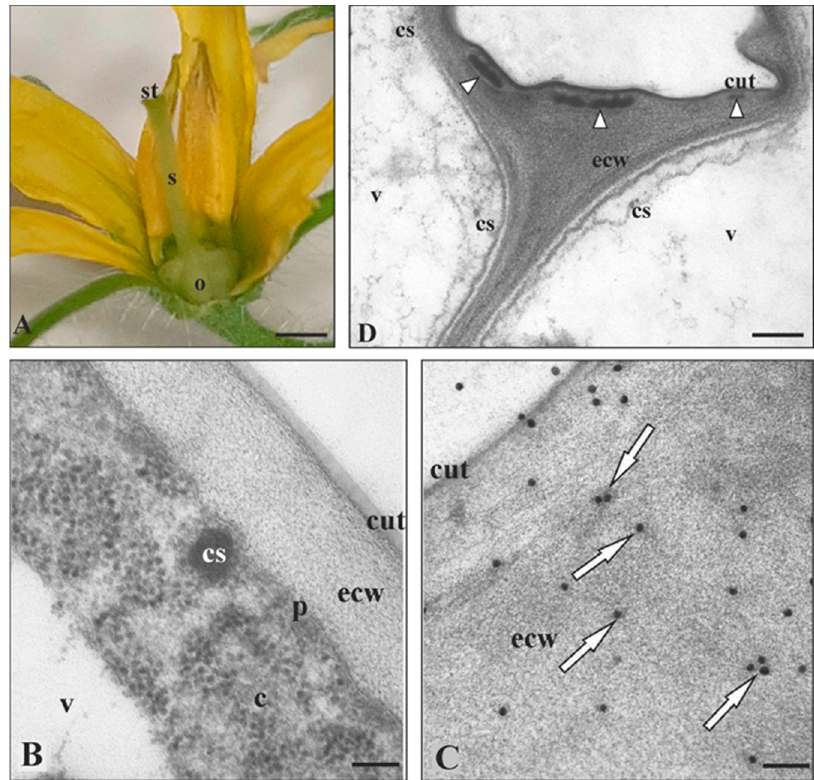
Figure 2. Cutinsome localization and identification in ovary of S. lycopersicum . ( A ) Mature flower with clearly visible ovary five days after anthesis. ( B – D , TEM images) In planta cutinsomes in cytoplasm and external cell wall of fruit epidermis, more or less visible depending on the fixation method. Preparations fixed in glutaraldehyde with ( B , D ) OsO 4 and ( C ) without OsO 4 . ( B ) Cutinsome with electron-dense contents near plasmalemma heading for external cell wall with clearly visible cuticle and ( D ) coalesced cutinsomes (arrow heads) forming cuticle layer. ( C , arrows) Cutinsomes after immunogold reaction with anti-cutinsome antibodies labeled with one to a few 20 nm gold grains. Single grains localize cutinsomes, although these structures are not clearly visible on the external cell wall; c, cytoplasm; cs, cutinsome; cut, cuticle; ecw, external cell wall; o, ovary; p, plasmalemma; s, style; st, stigma; v, vacuole; Bars, ( A ) 700 µm, ( B , C ) 100 nm, ( D ) 200 nm.